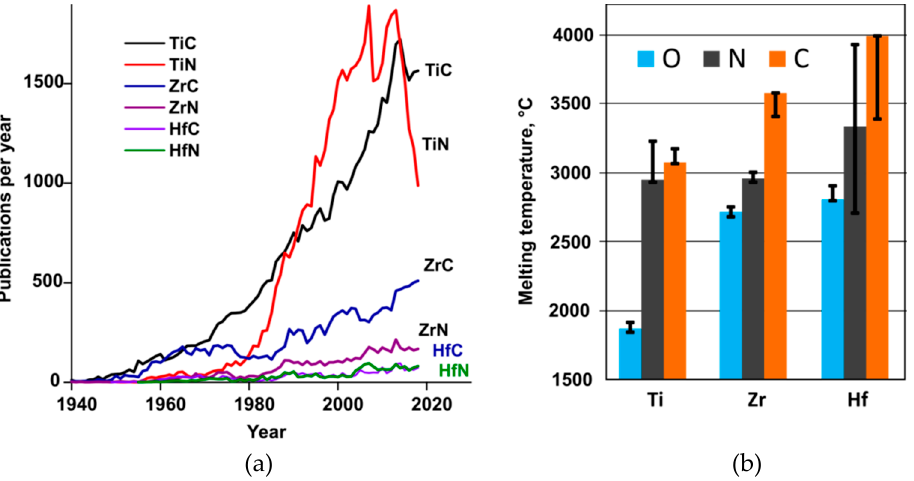
Figure 1. ( a ) Number of publications per year on carbides and nitrides of titanium group transitional metals (1940–2018 Chemical Abstract database). ( b ) The preferred values for melting temperatures of Ti, Zr, and Hf carbides and nitrides with NaCl-type structure. See Section 4 for references. The “error bars” indicate the range of previously reported values for melting temperatures from Berg et al. [7].